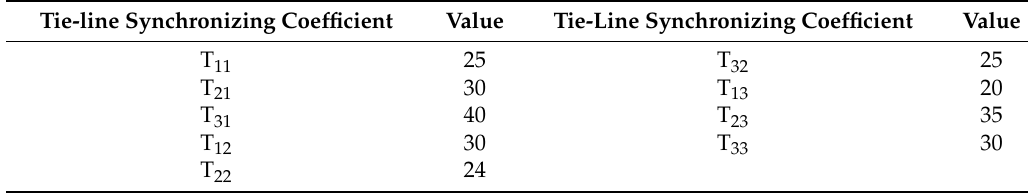
Table A3. Value of tie-line synchronizing coefficient for Figure